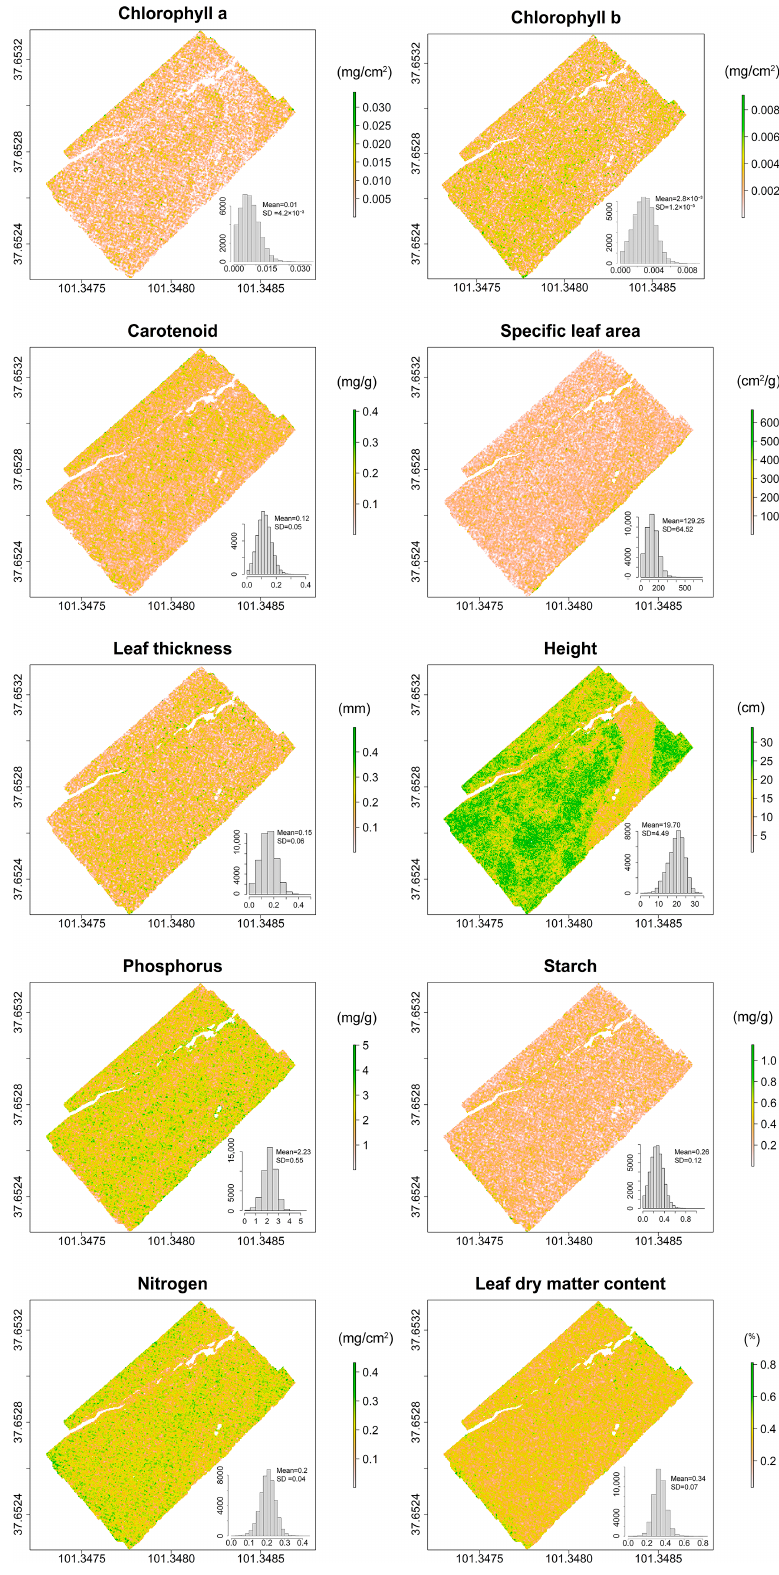
Figure 6. Spatial patterns of plant community traits mapped using GA-PLSR and the frequency distribution of pixel values. The location of this image was indicated in Figure 1. This image covers plot 32, plot 33 and plot 34 in Figure